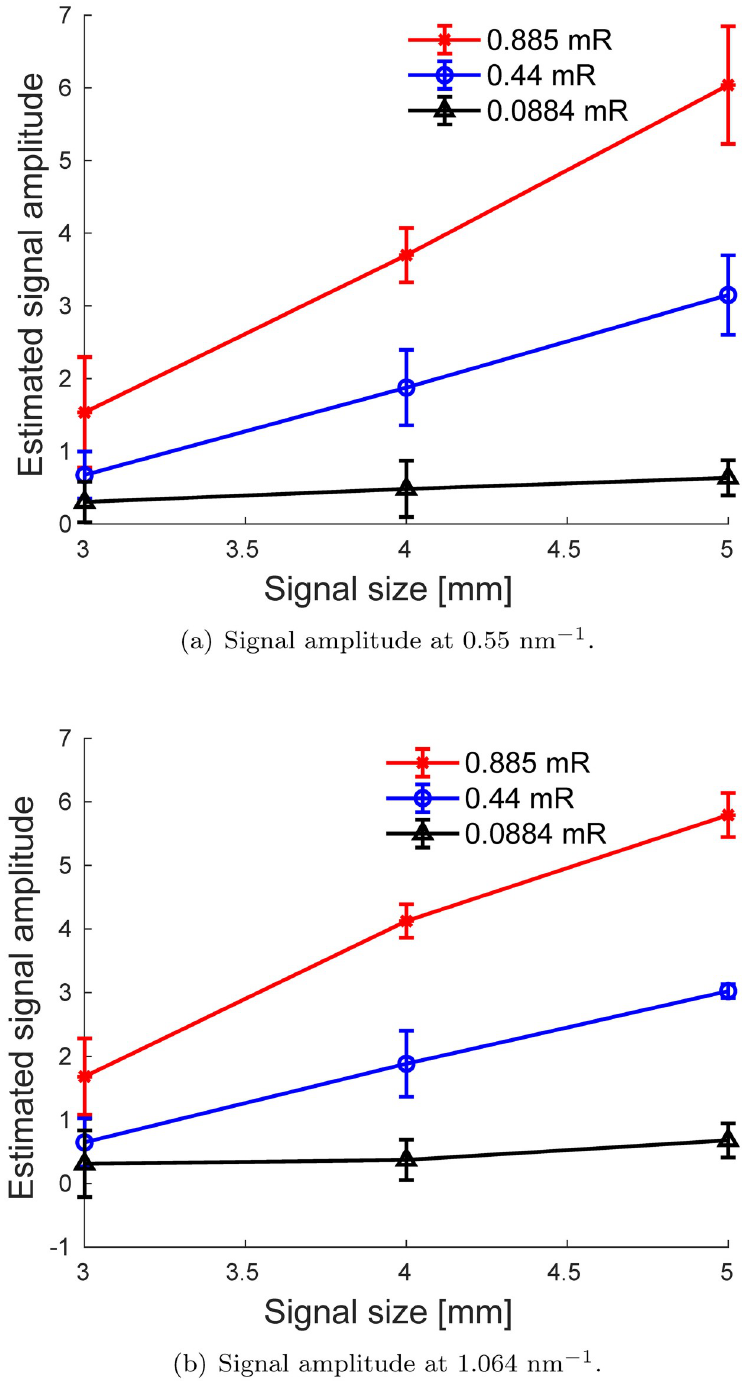
Fig 5. Comparison between the average estimated signal amplitude for the amyloid diffraction peaks shown in Fig 4, for three different exposure levels. The vertical error bars correspond to ± 1 standard deviations computed from 10 independent